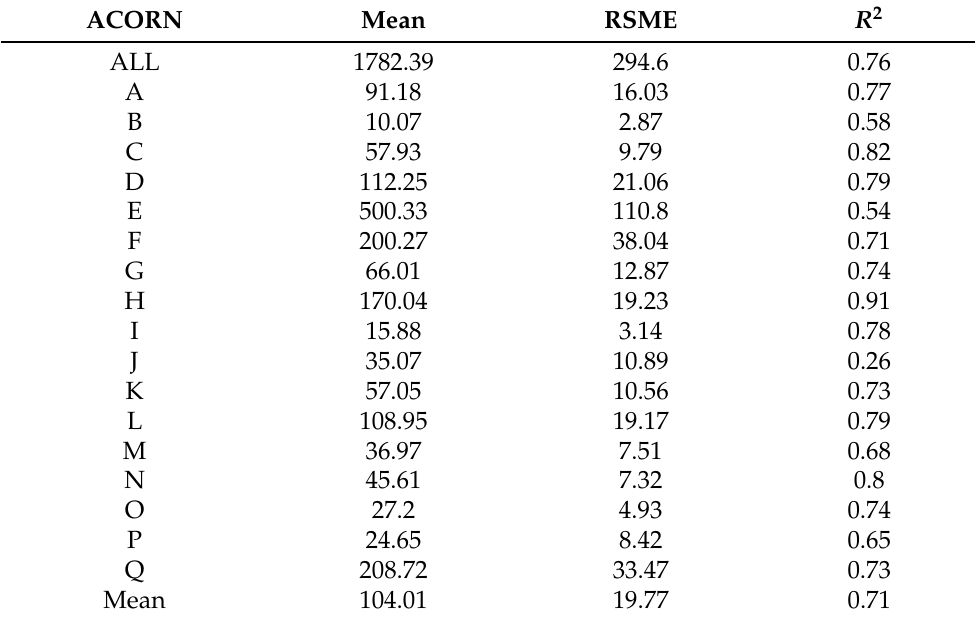
Table 1. Summary of Random Forest models performance for each Acorn group and ALL data without previous